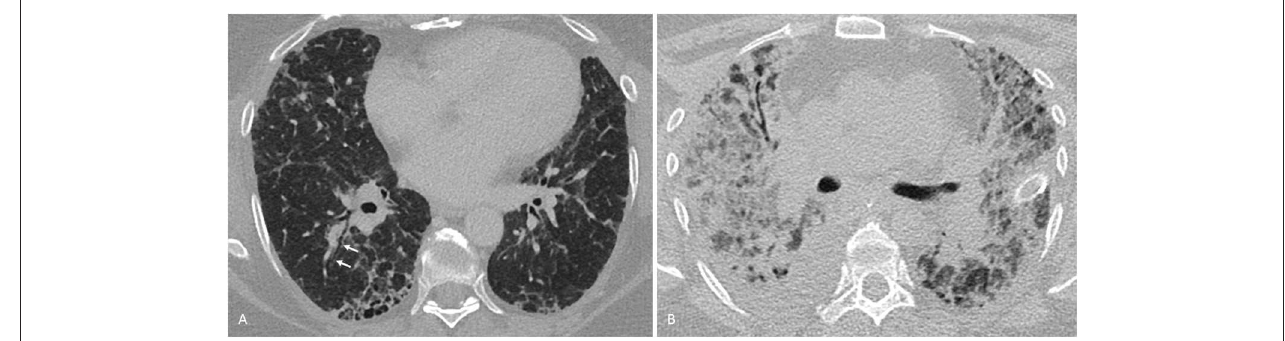
FIGURE 2 | Interstitial lung disease in a 56-year-old woman with rheumatoid arthritis. (A) One millimeter transverse axial CT-section through the lung bases show subpleural honeycombing and early traction bronchiectasis (arrows), consistent with a usual interstitial pneumonia pattern. (B) Nine months later, the patient developed severe dyspnea at rest and required mechanical ventilation. On bronchoalveolar lavage, influenza A virus was found to be present. A follow-up CT now showed a small right-sided pleural effusion and multifocally confluent consolidation, partially obscuring equally patchy bilateral ground-glass opacification. A few thickened septae (crazy-paving pattern) could be delineated (not shown). These findings were consistent with a viral pneumonia. Despite extracorporeal membrane oxygenation therapy, the patient